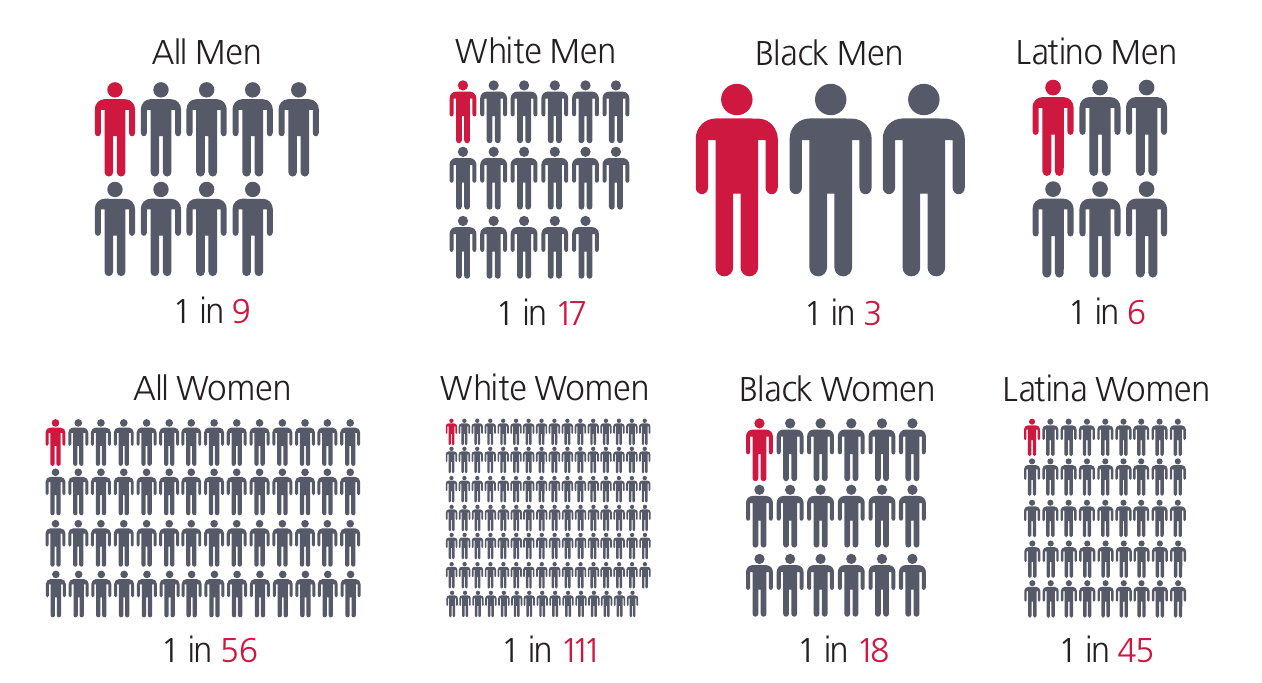
Source: Bonczar, T. (2003). Prevalence of Imprisonment in the U.S. Population, 1974-2001. Bureau of Justice Statistics. Available at: http://www.bjs.gov/content/pub/pdf/piusp01.pdf (p. Black Lives Matter: Eliminating Racial Inequity in the Criminal Justice System 11